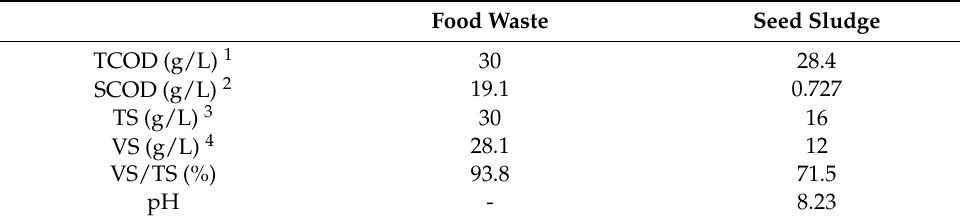
Table 2. Chemical characteristics of food waste and seed sludge.